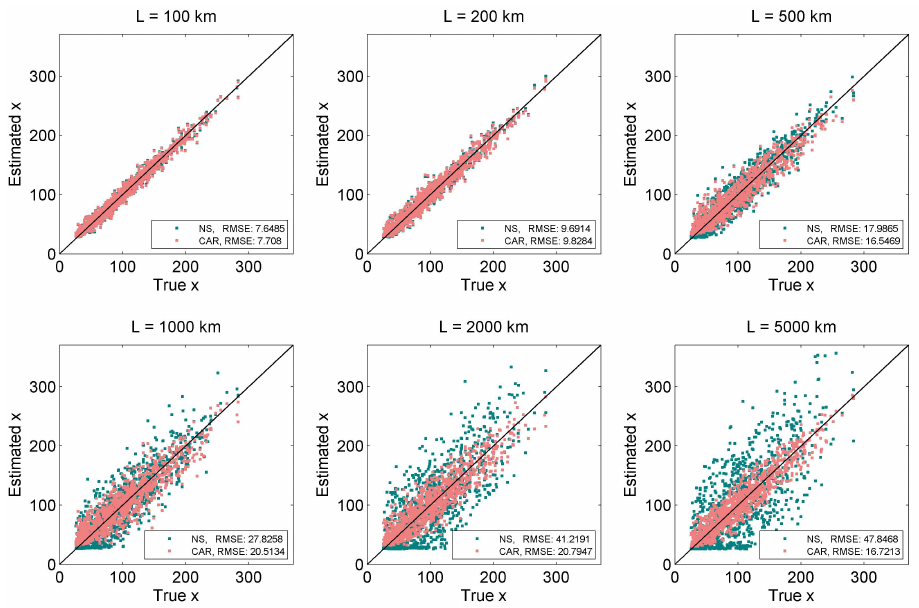
Fig. 5. Scatter plots of “true” x i versus estimated x i (in units of TgCOyr − 1 ) for the FFBF North America (FFBF-NAM) source category computed from 1000 synthetic data sets. RMSE is the root mean square error metric of the estimated x i from the “true” x i .